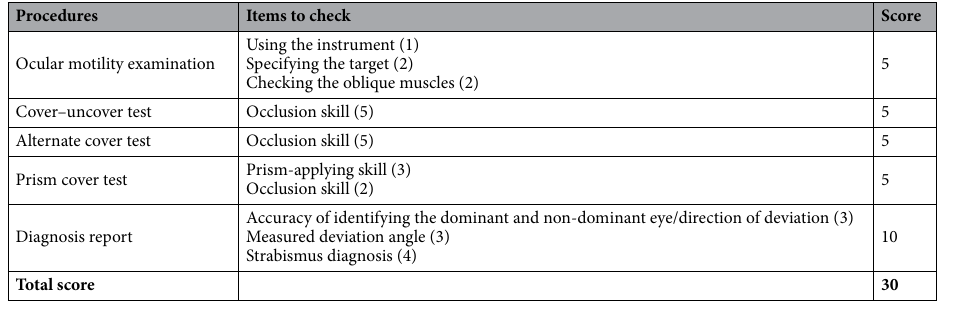
Table 1. Accuracy score rating standard of the diagnostic procedure for